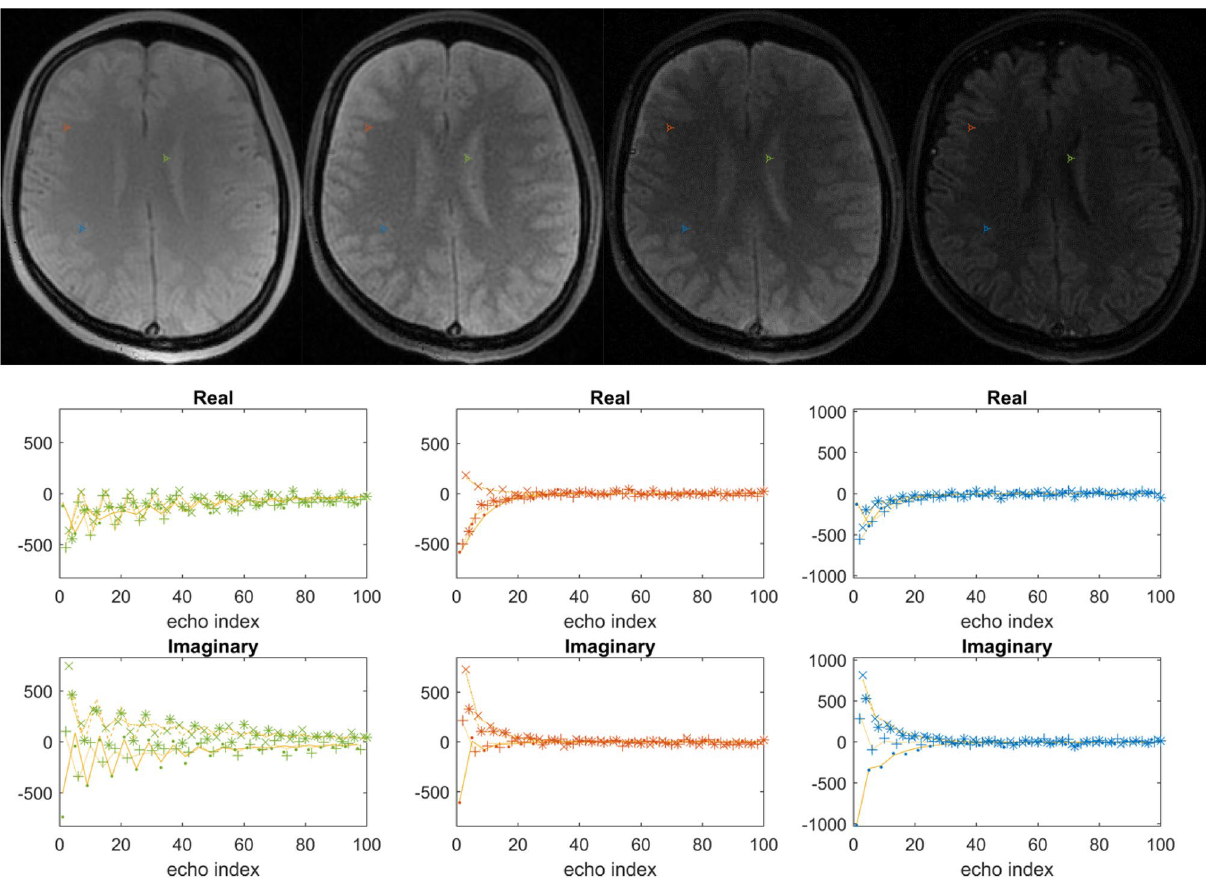
Figure 5. The first row shows the transient contrast at different time points along the acquisition in a balanced pulse sequence for the propagator as a composite of pulses according to the “ α x − γ y − α y − γ x ” MP-b-nSSFP scheme. The second and third rows show the signal and fit for three highlighted voxels from three different tissues. The observations of the four different echoes in each block of the propagator is shown with different symbols (., + , × Figure 5 shows images and different time points of the signal evolution and the signal evolution for three different tissues using as propagator the “ α x − γ y − α y − γ x ”scheme in a balanced pulse sequence. The banding artifact is gone and the signal evolution is also described by the same theoretical model (see Eq. 1).